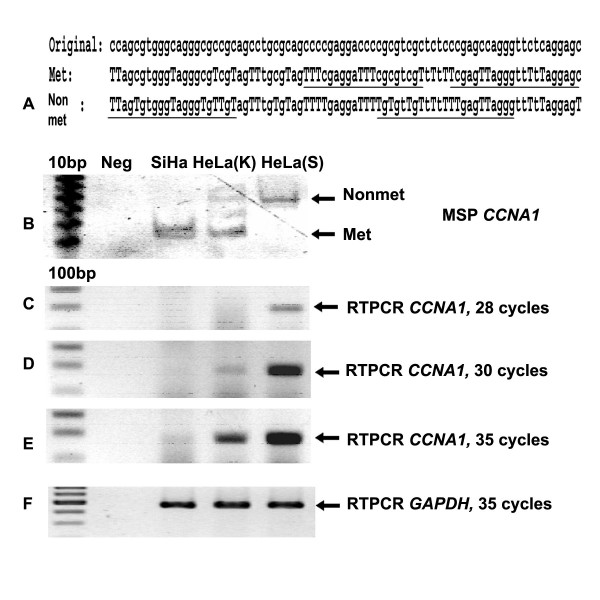
Schematic representation of inverse correlation between promoter methylation and expression of CCNA1 in CC cell lines. (A) Diagram of methylated and non-methylated sequences after bisulfite modification covering the area of both primers (underlined) in the promoter region of CCNA1. M, DNA size marker. Top panel, 10-bp ladder; bottom four panels, 100-bp ladder. Neg, negative. (B) Duplex MSP analysis of cell lines. Upper and lower arrows indicate non-methylated and methylated amplicons, respectively. MSP, methylation-specific PCR. (C-E) RT-PCR of the CCNA1 gene after 28, 30 and 35 cycles, respectively. (F) RT-PCR of the GAPDH gene as an internal control.